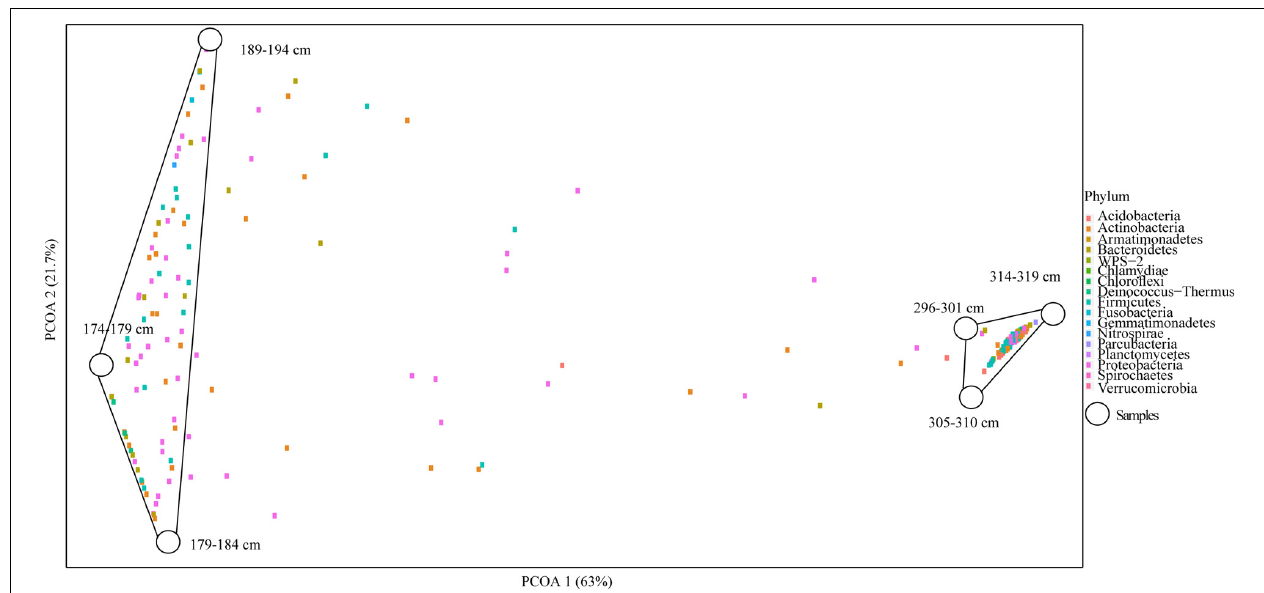
FIGURE 2 | PCoA biplot of the OTU composition in Holocene ( n = 3) and Pleistocene ( n = 3) aged samples. Combined Axis 1 (PCOA1) and Axis 2 (PCOA2) components explained a total of 84.7% of the dissimilarity between the clusters in the system ( p = 0.022). Samples 174–179, 179–184, 189–194 cm formed the Holocene cluster (8–10 k cal yr BP) and 296–301, 305–310, 314–319 cm formed the Pleistocene aged cluster (14–15 k cal yr BP). In the ordination space, samples (5 cm segments of DHL_16-1 and 2) have been shown with white circles and OTUs with colored squares. Colors of OTUs represent their taxonomic identity at the phylum